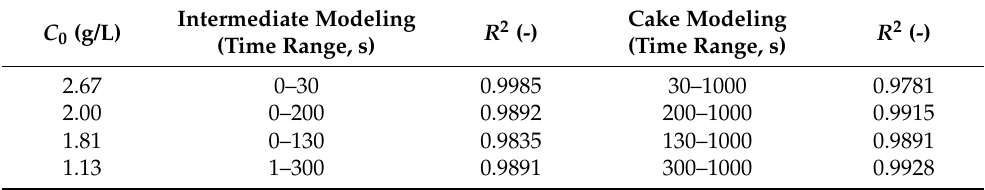
Table 7. The transition of fouling mechanisms with time at different feed